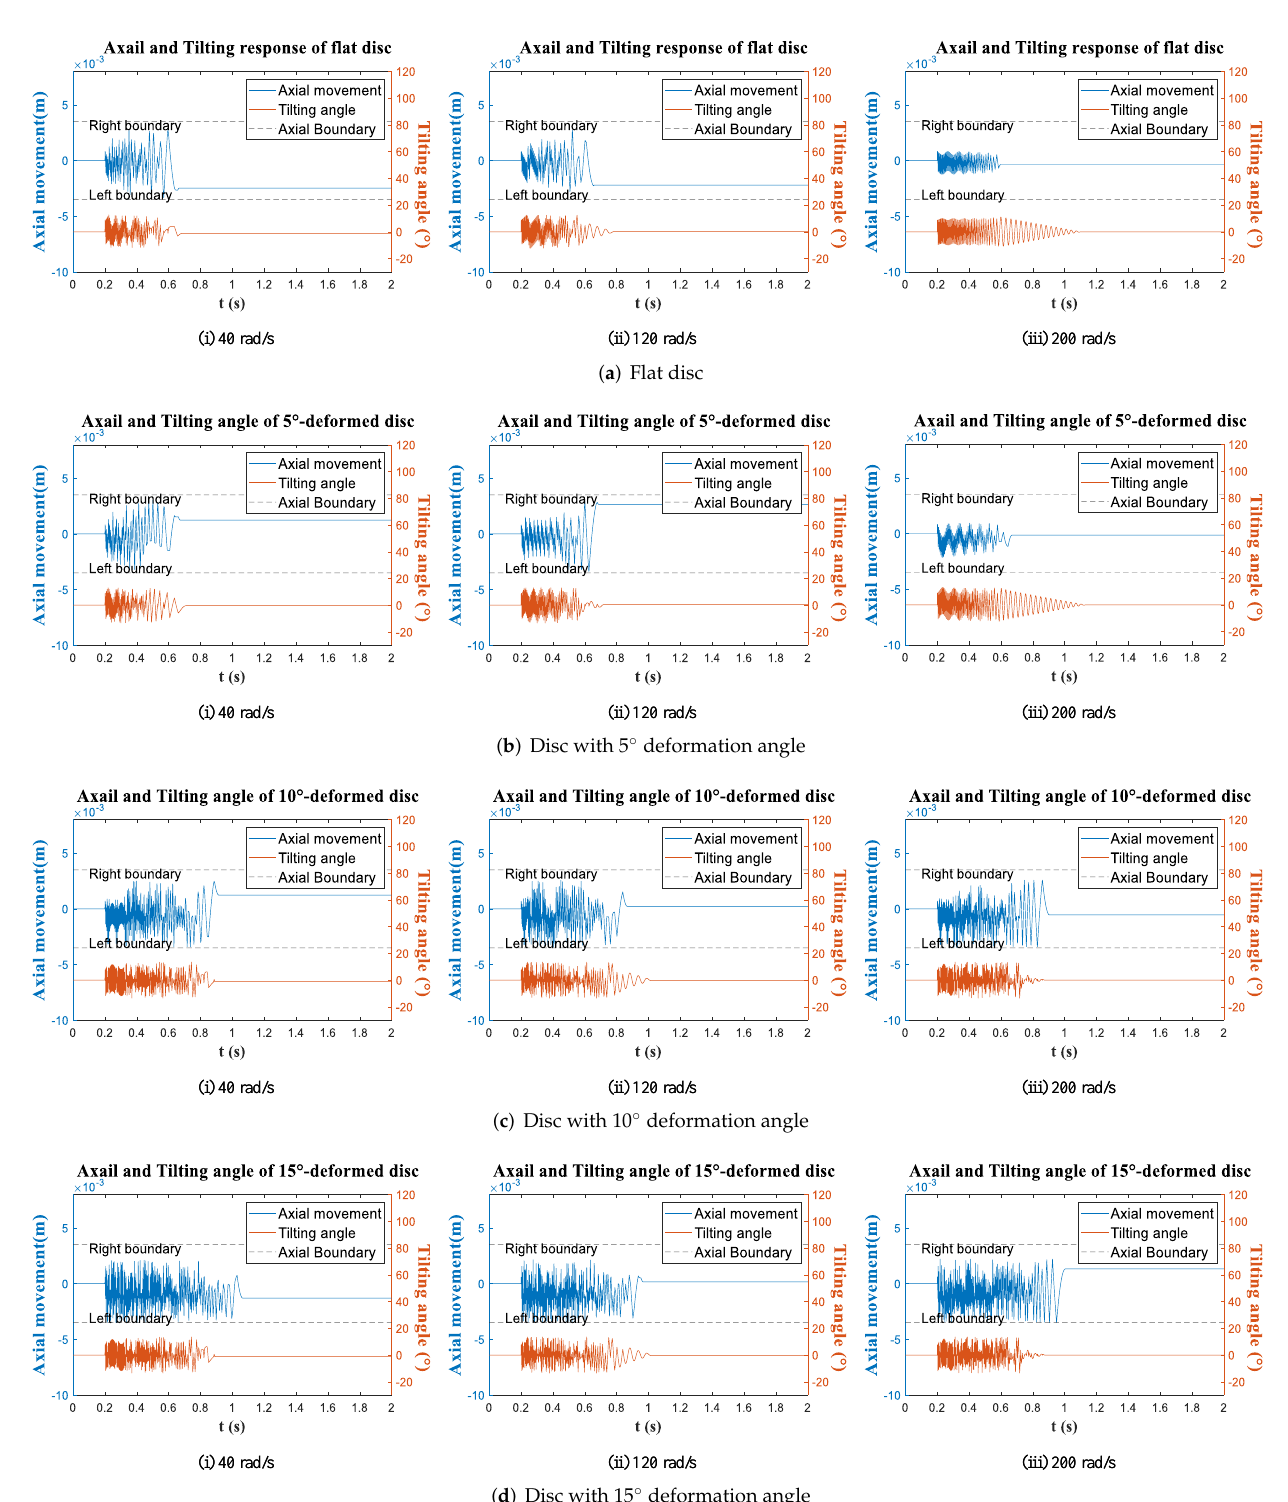
Figure 10. Time response: BC = 7 mm, initial force = 7